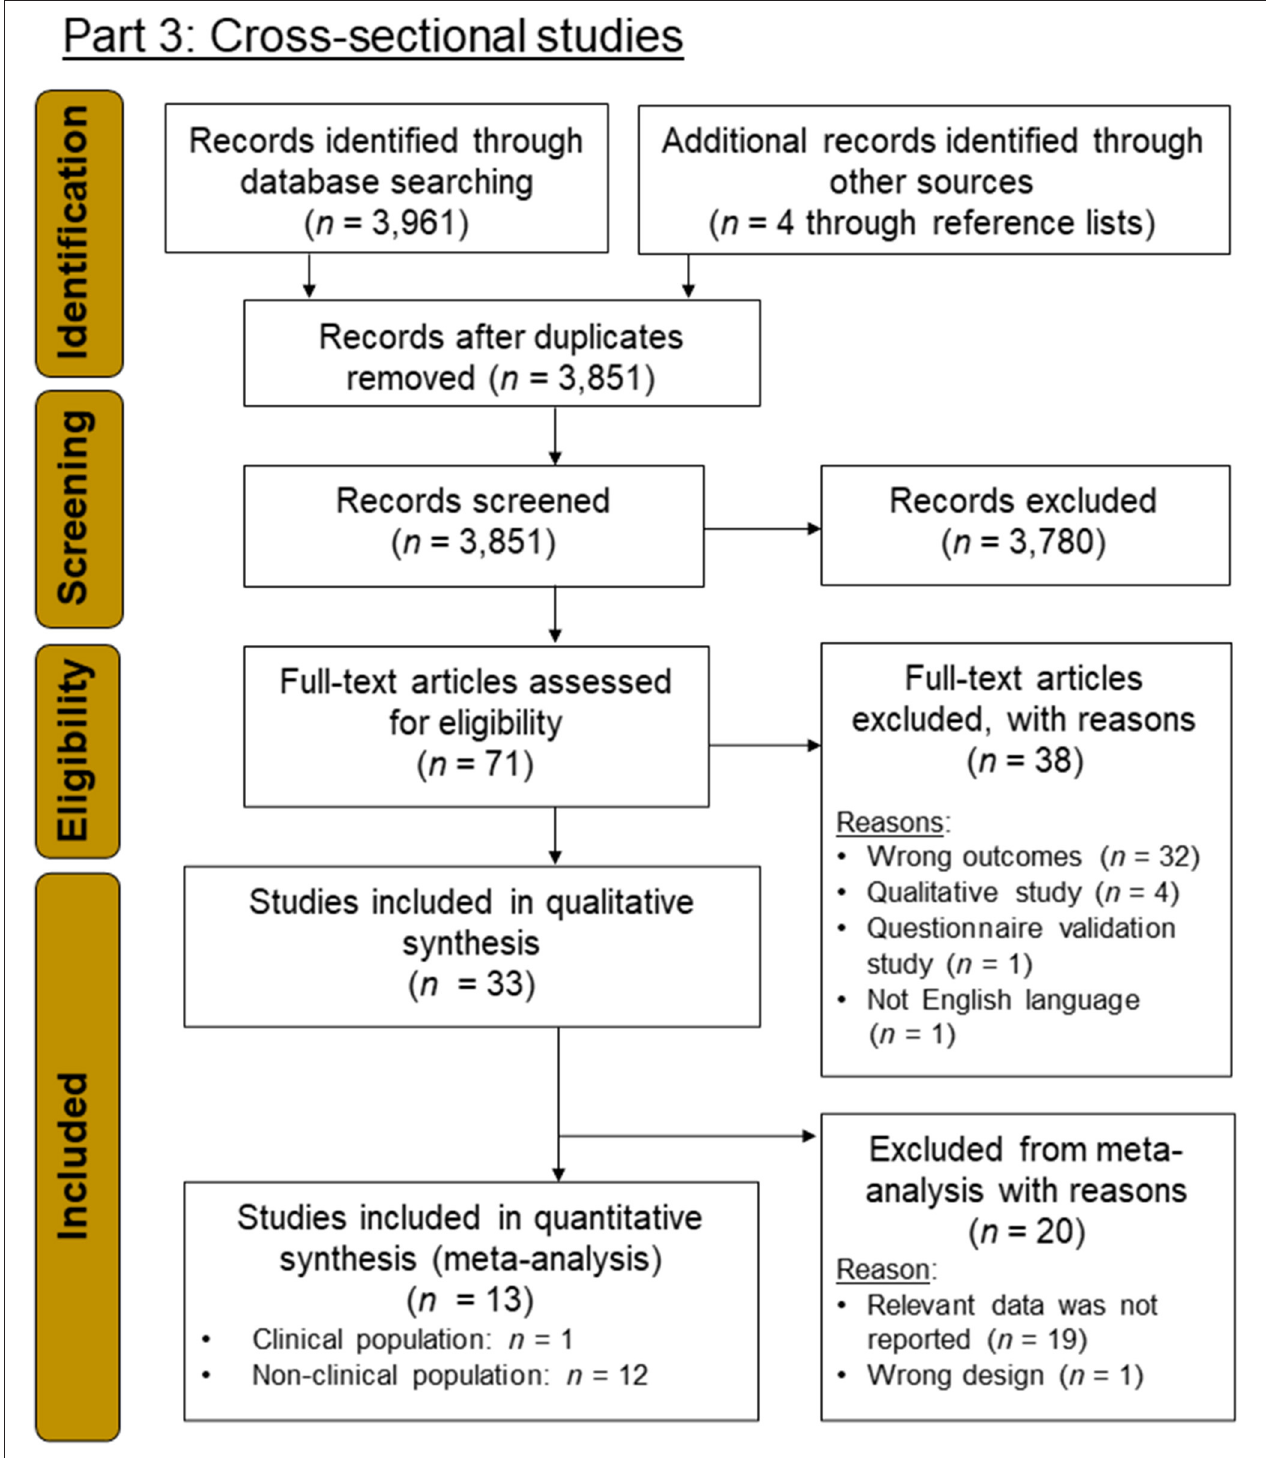
FIGURE 4 | PRISMA flow-chart diagram (Moher et al., 2009) for part 3 in which cross-sectional studies were searched for.